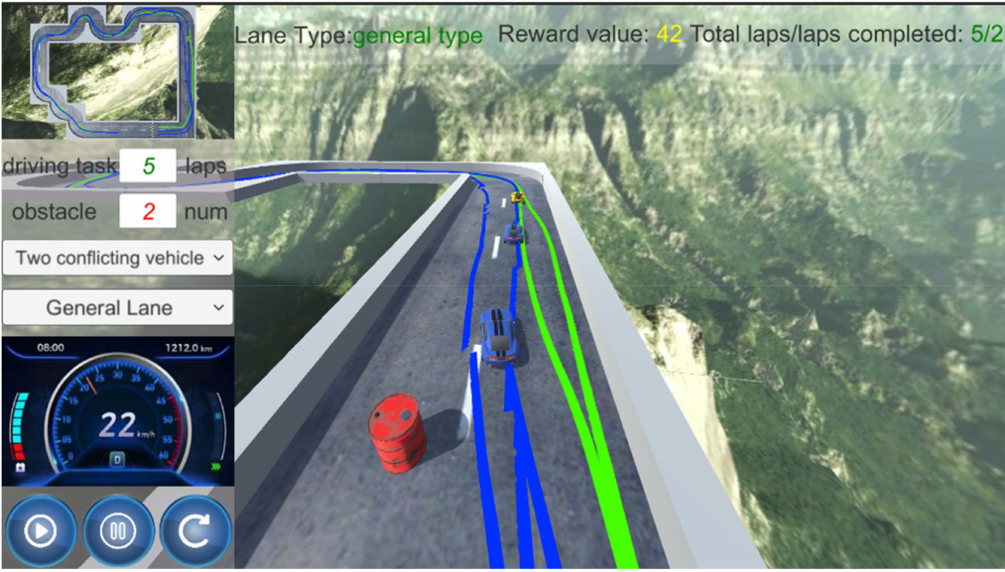
Figure 18. Overall effect of the